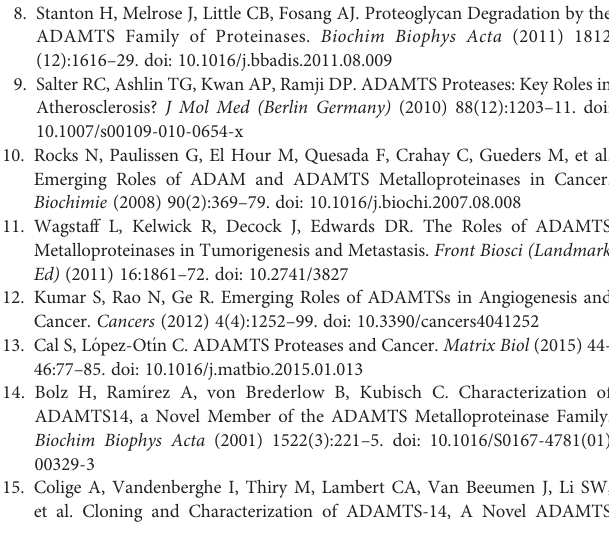
Supplementary Figure 1 | The mRNA expression levels of ADAMTS14 in pan- Cancer from TCGA and GTEx datasets. *** P < 0.001; Supplementary Figure 2 | The expression patterns of ADAMTS14 in cell lines from CCLE database; (A) Various cancer cell lines; (B) Renal cancer cell lines; Supplementary Figure 3 | ADAMTS14 could serve as an independent prognostic factor for ccRCC in TCGA dataset; (A) Univariate cox regression analysis; (B) Multivariate cox regression analysis; Supplementary Figure 4 | The Gene Ontology (GO) analysis of ADAMTS14 in ccRCC patients in TCGA dataset. Supplementary Figure 5 | Prediction of ADAMTS14 related immune responses of immunotherapy in ccRCC patients by TCIA dataset; (A) Distribution of ADAMTS14 expression in scores of CTLA4 negative and PD1 negative; (B) Distribution of ADAMTS14expressioninscoresofCTLA4negativeandPD1positive; (C) Distribution of ADAMTS14 expression in scores of CTLA4 positive and PD1